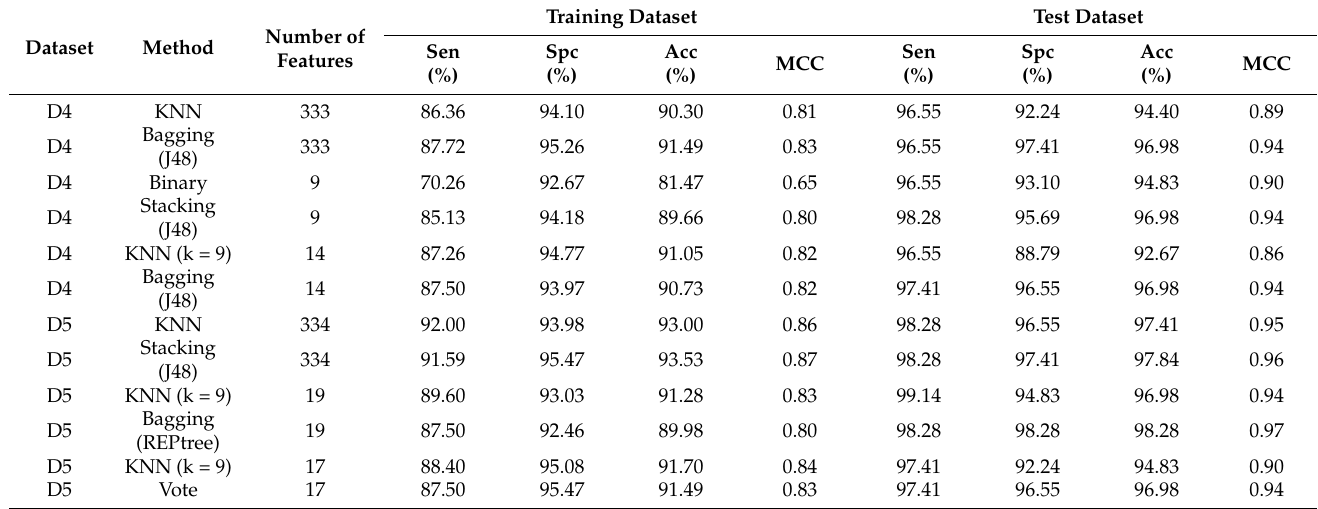
Table 2. In the mixed datasets D4 and D5 of ACPs, excellent models were developed based on a variety of algorithms and different